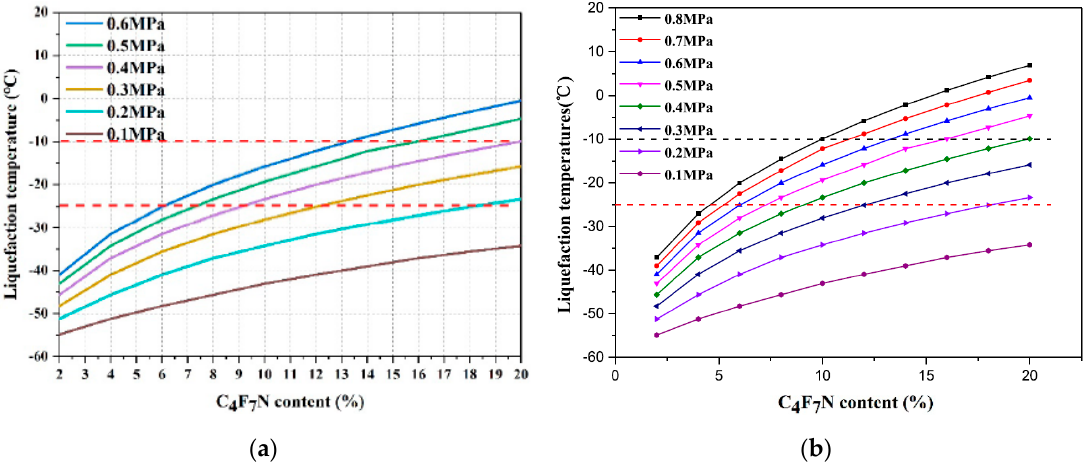
Figure 6. Liquefaction temperature of the gas mixture at different gas ratios and pressures. ( a ) Novec TM /Nitrogen (N 2) [27] and ( b ) Novec TM /CO 2 [58].